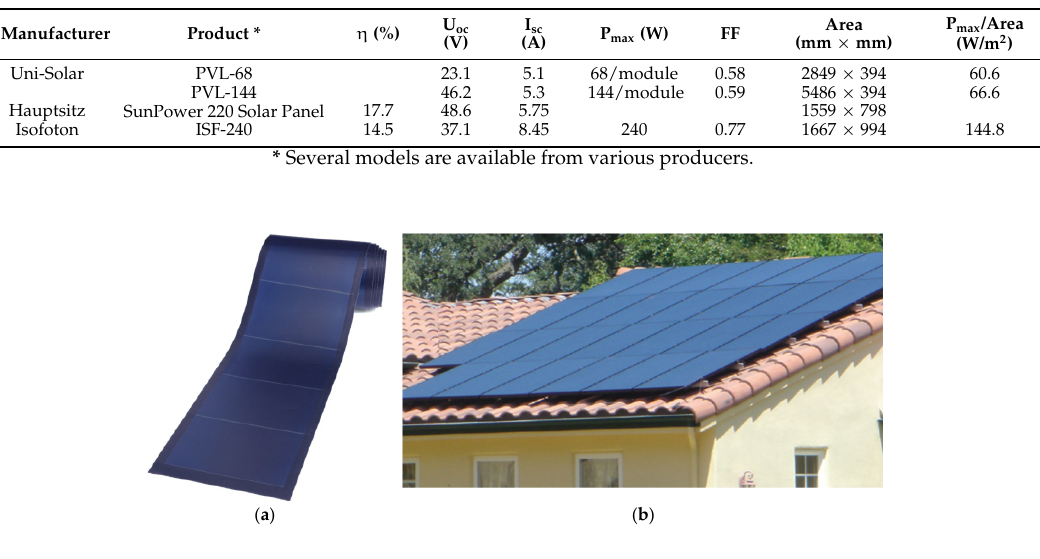
Table 5. Literature data for some of the building attached photovoltaic (BAPV) products [3].